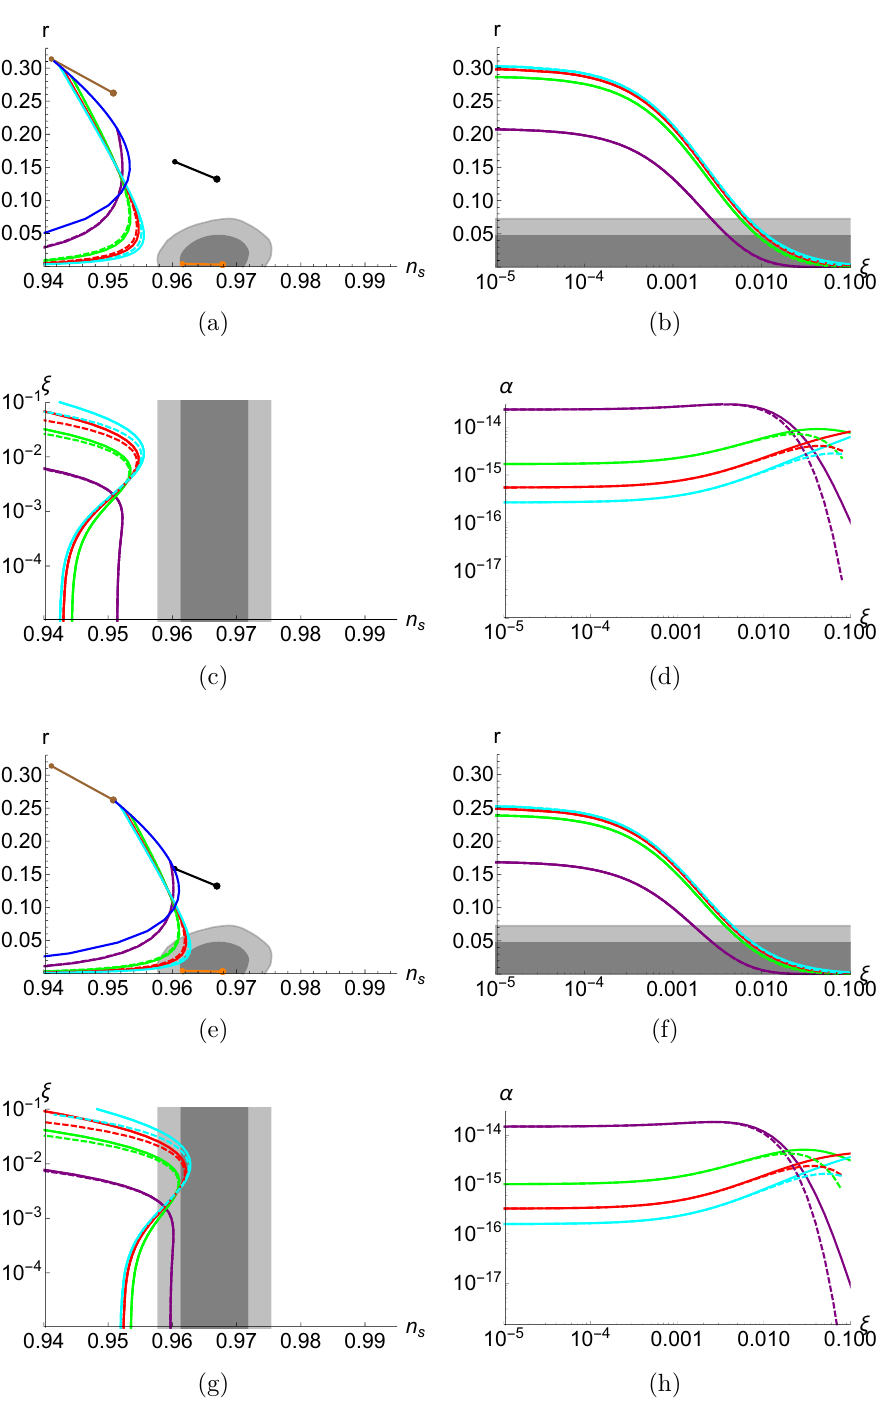
Figure 6. r vs. n s (a,e), r vs. ξ (b,f), ξ vs. n s (c,g) and α vs. ξ (d,h) for δ = 10 2 , 4 , 6 , 8 respectively in purple, green, red and cyan with N e = 50 , 60 e -folds in region 1. Continuous/dashed line represents metric/Palatini gravity. For reference we plot the predictions of CW inflation for N e = 50 , 60 (blue), R 2 (orange), χ 2 (black) and χ 4 (brown) inflation for N e ∈ [50 , 60] . The gray areas represent the 1,2 σ allowed regions from Planck 2018 data